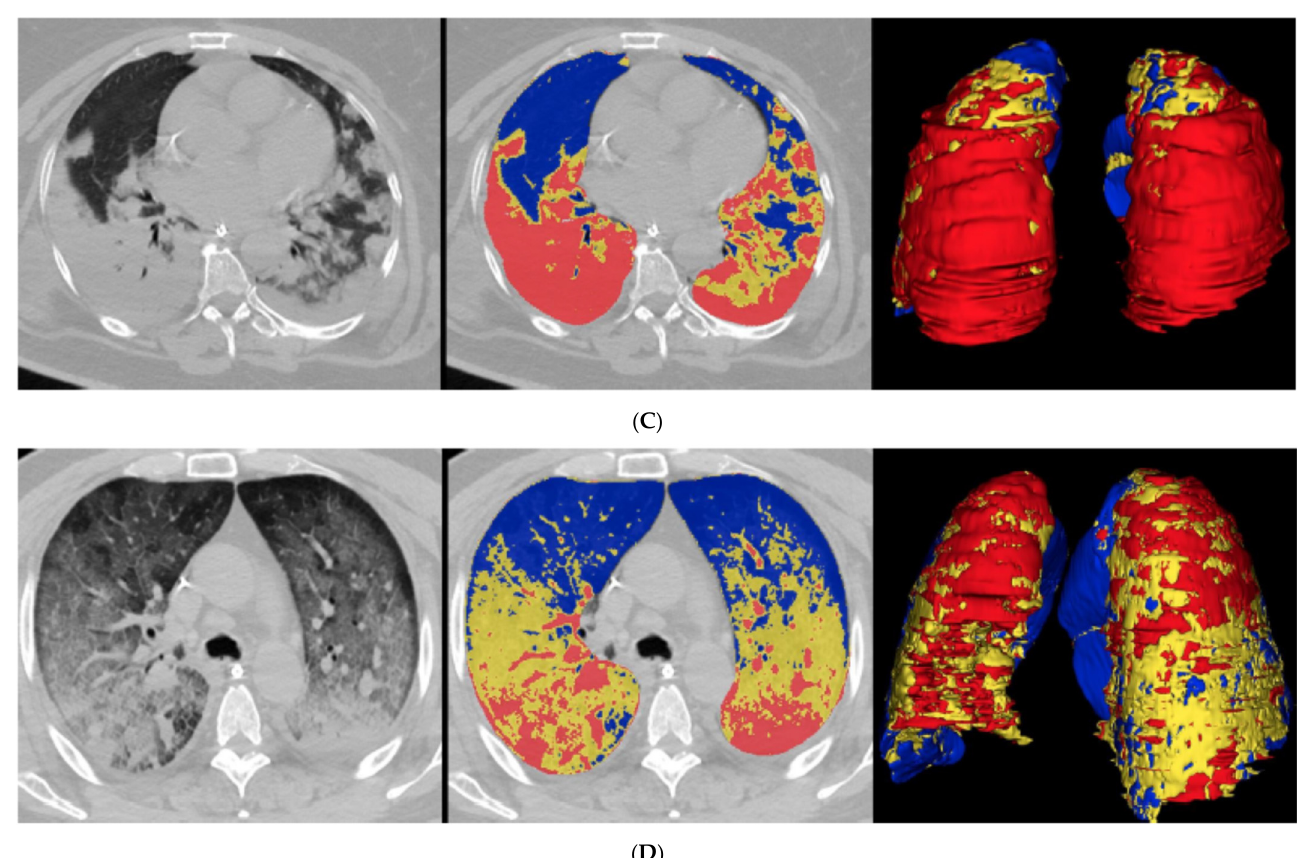
Figure 1. Unenhanced CT scan and QCT analysis in four patients with COVID-19 pneumonia. ( A , B ) show one QCT with %CL < 23% and one with %CL > 23%. ( C , D ) highlight the texture differences between the “poorly aerated” volume (%PAL,